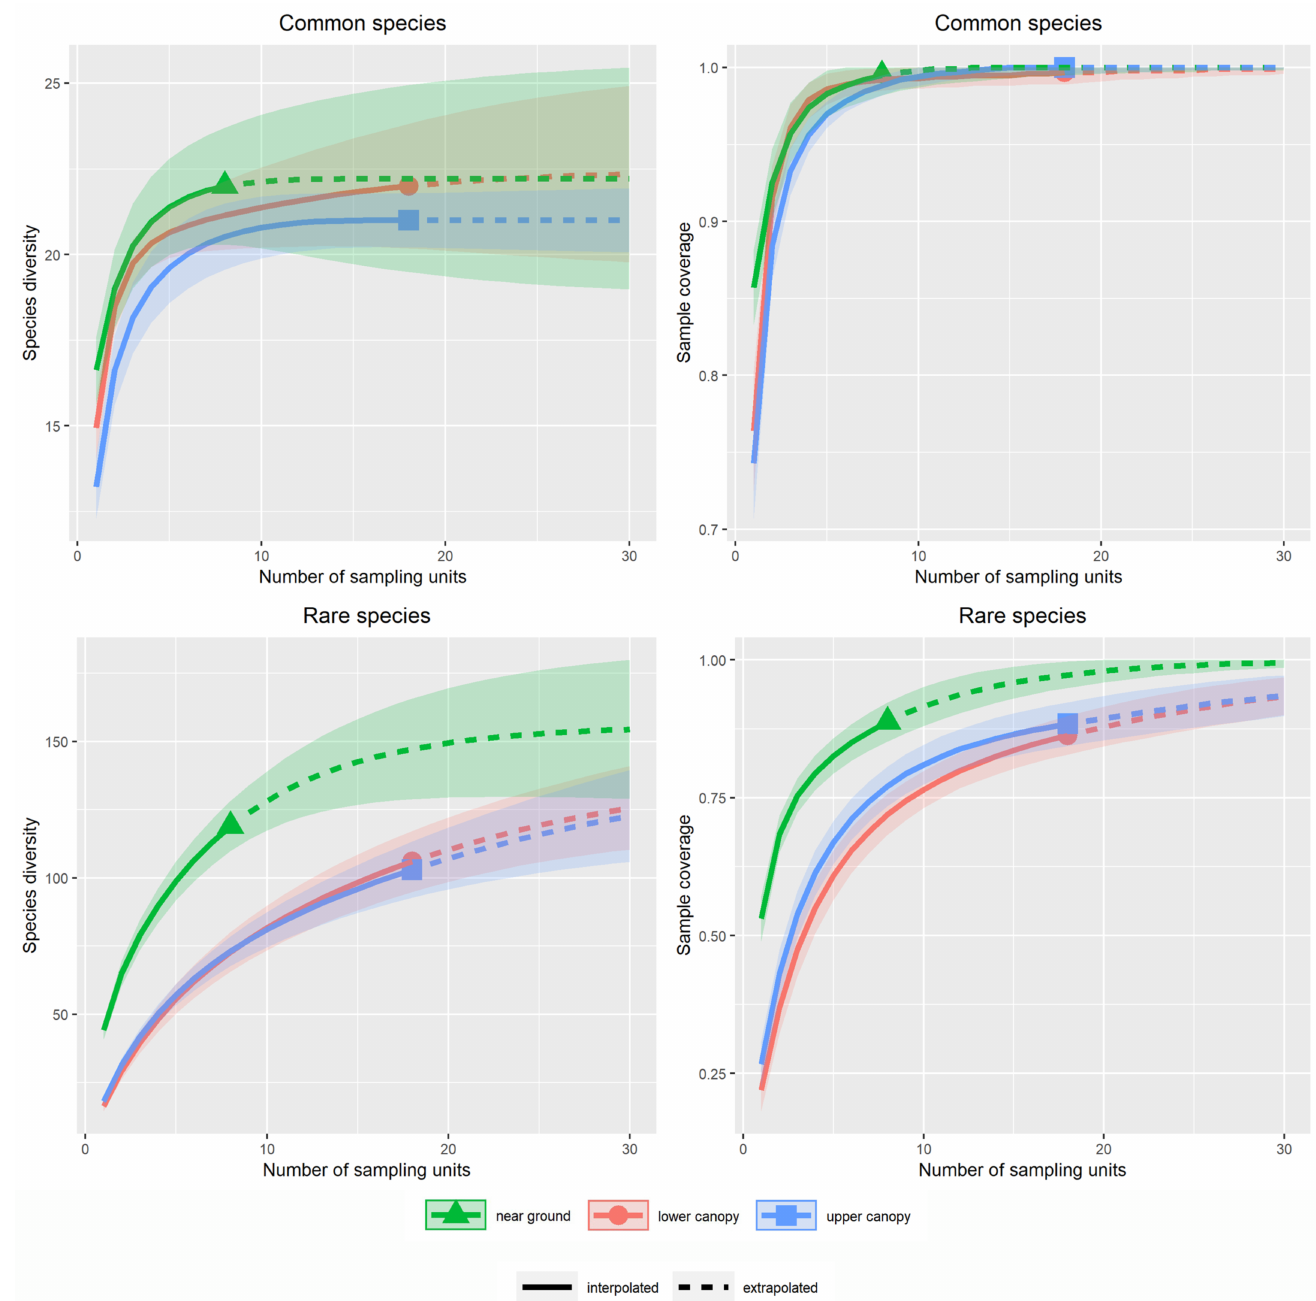
Figure A6. Comparison of species richness and sample coverage among the studied strata for rare and common beetle species, rarity classification according to the